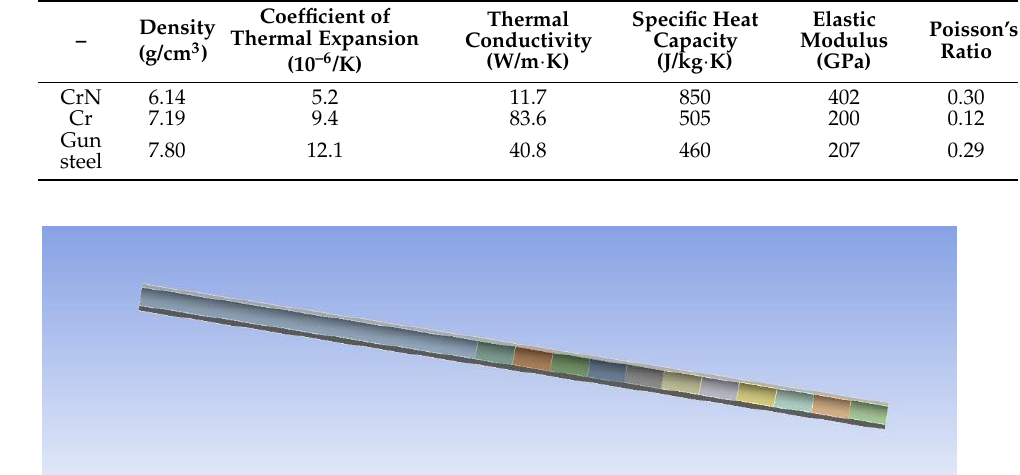
Table 1. The thermodynamic parameters of gun barrel and coating materials.